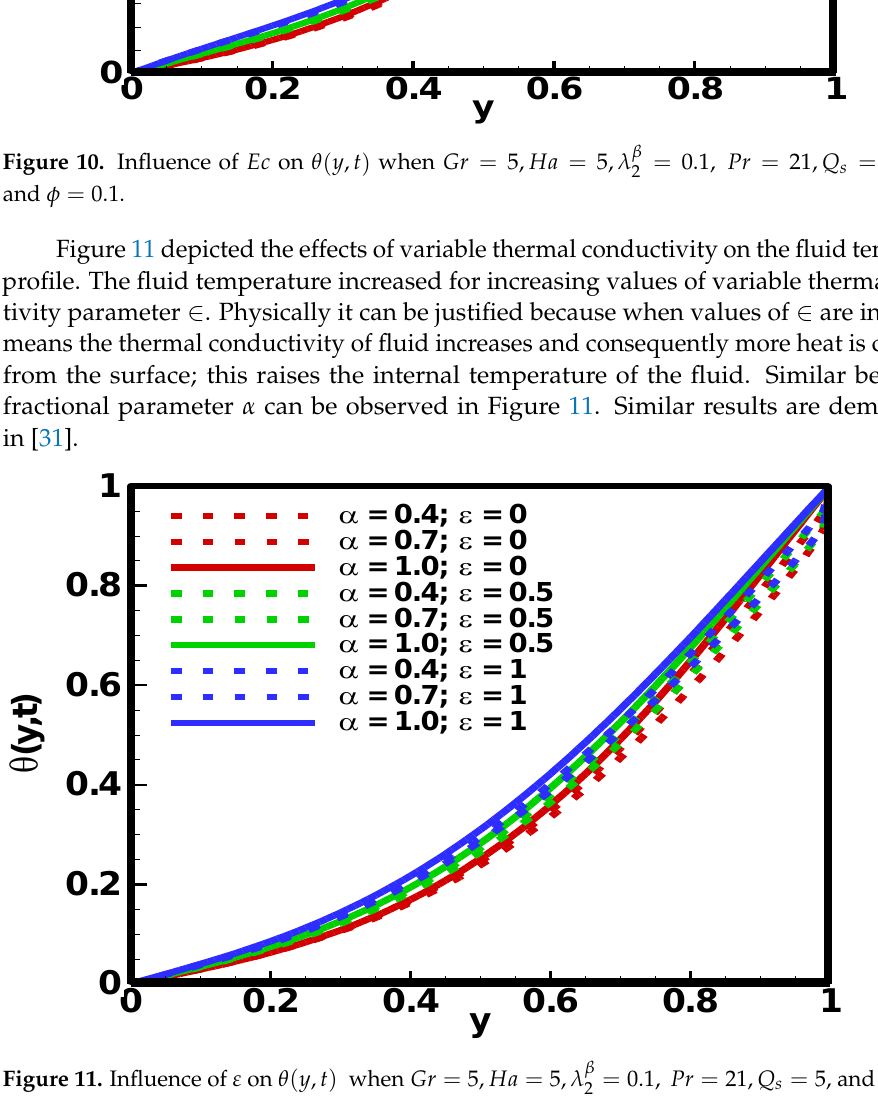
Figure 11. Influence of ε on θ ( y , t ) when Gr = 5, Ha = 5, λ β